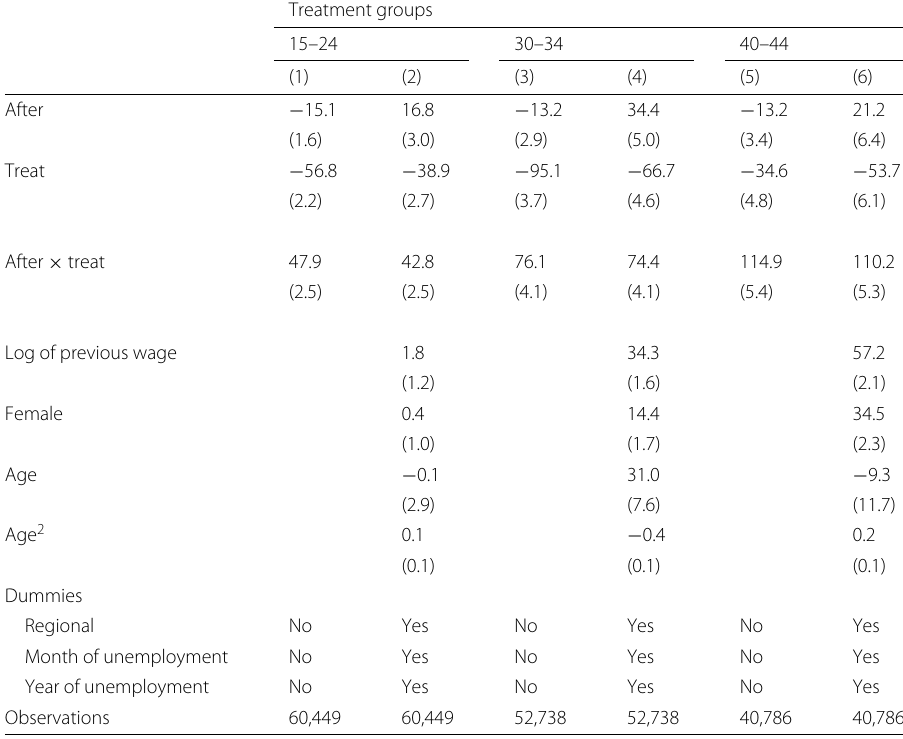
Table 3 The impact of the reform, difference-in-differences estimates (in